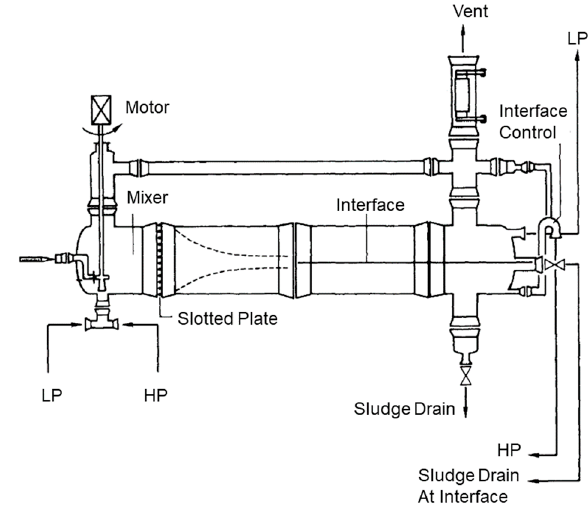
Figure 5. Schematic drawing of a mixer–separator [28].